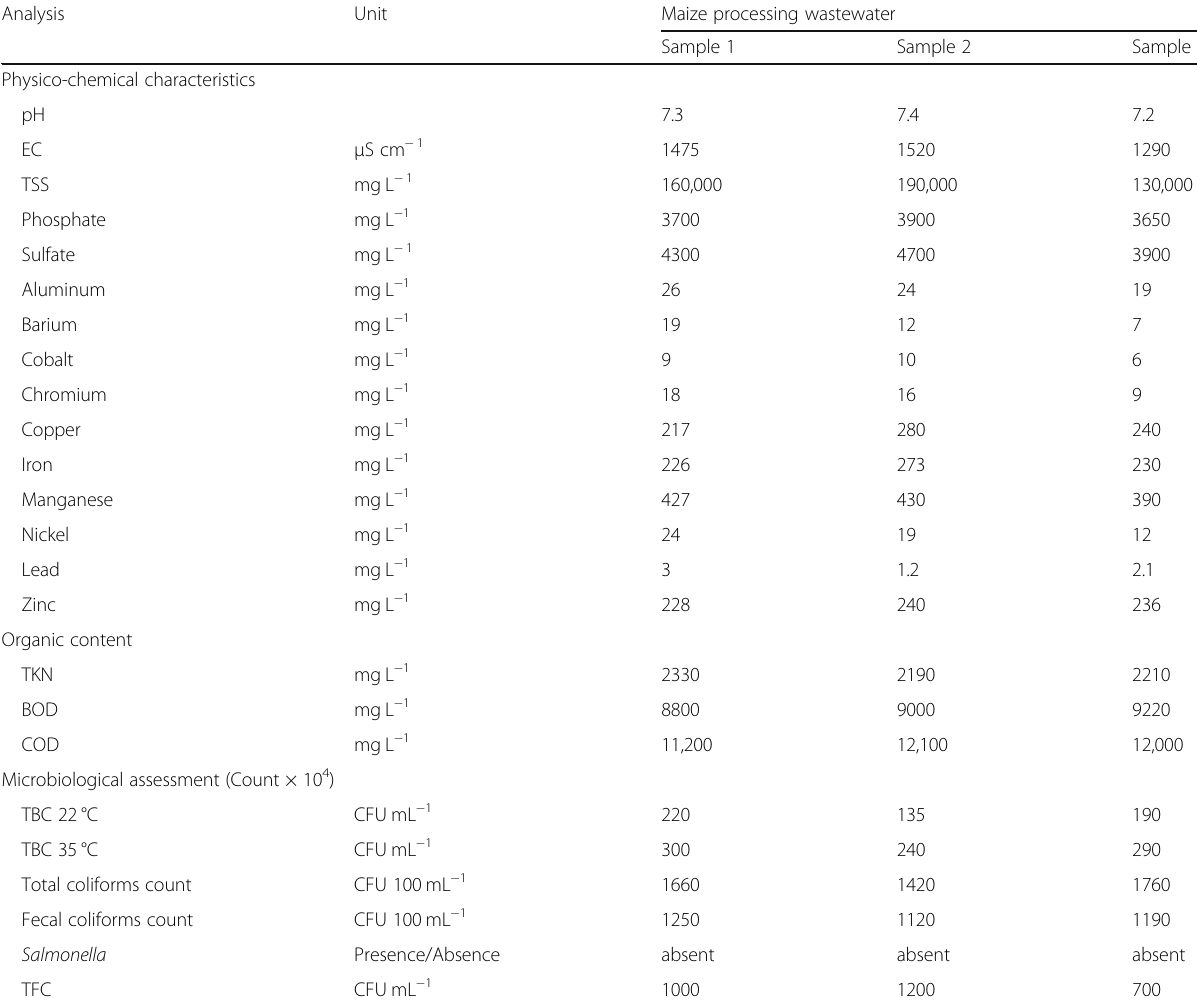
Table 1 Quality assessment of maize processing wastewater samples